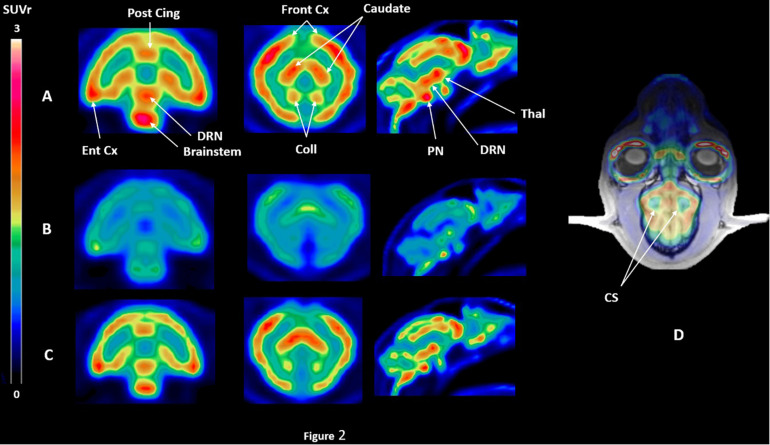
SUVr PET images of [18F]F13640 binding in the three experimental conditions for one cat, i.e., (A) control conditions, (B) pre-injection of d-fenfluramine 30 min before PET acquisition, using the centrum semiovale as a reference region (D). SUVr images are averaged from 32 to 90 min time of acquisition; (C) injection of d-fenfluramine 30 min after PET acquisition beginning (Post cing, posterior cingulate cortex; Front Cx, frontal cortex; Caudate, caudate putamen; Ent Cx, entorhinal cortex; DRN, dorsal raphe nucleus; PN, pontine nucleus; Thal, thalamus; Coll, colliculi; CS, centrum semiovale).